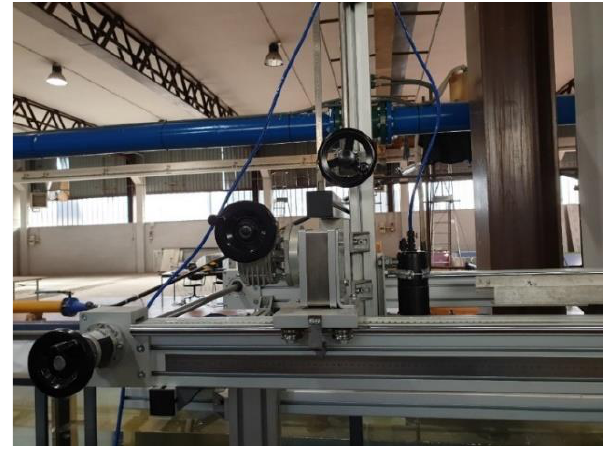
Figure 4. 3D instrument moving system of graduation scales.